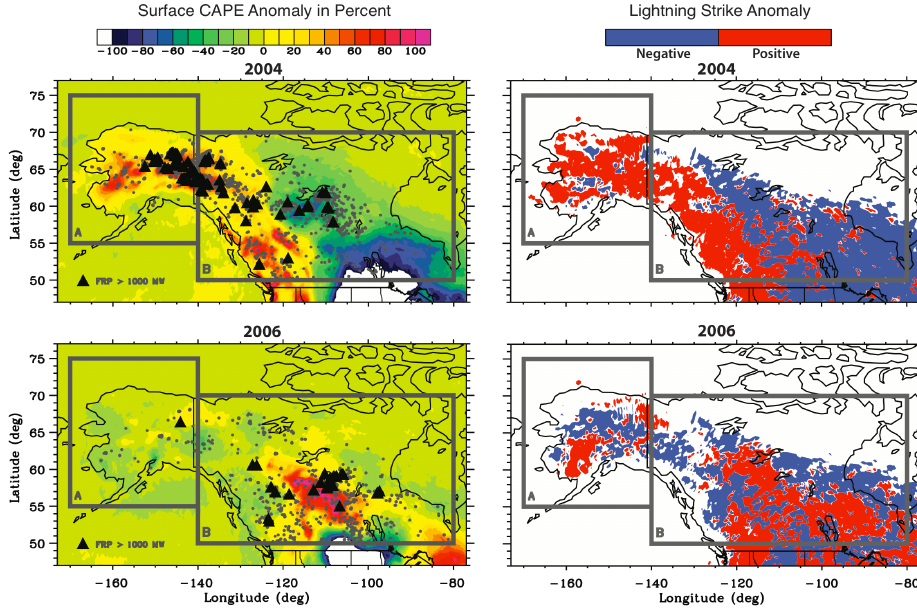
Figure 2. Fig. 2. (Left) Surface CAPE anomaly in percent (color filled) overlaid with MODIS fire data for the fire seasons of 2004 (top) and 2006 (bottom). The MODIS fire pixels are denoted as grey dots except those with FRP > 1000MW which are highlighted as black triangles. (Right) Positive and negative anomalies for total lightning strikes during the fire season of 2004 (top) and 2006 (bottom). All anomalies are based on the 7-year (2000–2006) study interval, and the regional study domains for Alaska and Canada ( A and B ) are highlighted with grey